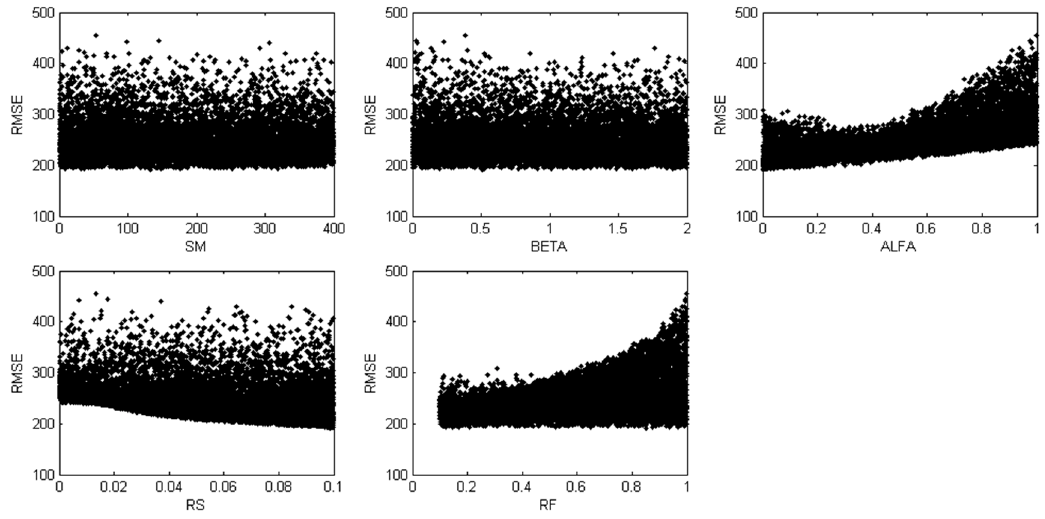
Figure 8. Scatter plot of RMSE against parameter values with 10,000 runs for Hymod model.